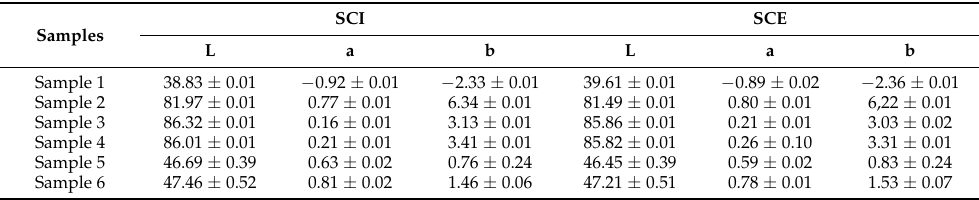
Table 2. Colorimetric analysis of all samples. Data found including (SCI) and excluding (SCE) specular component.